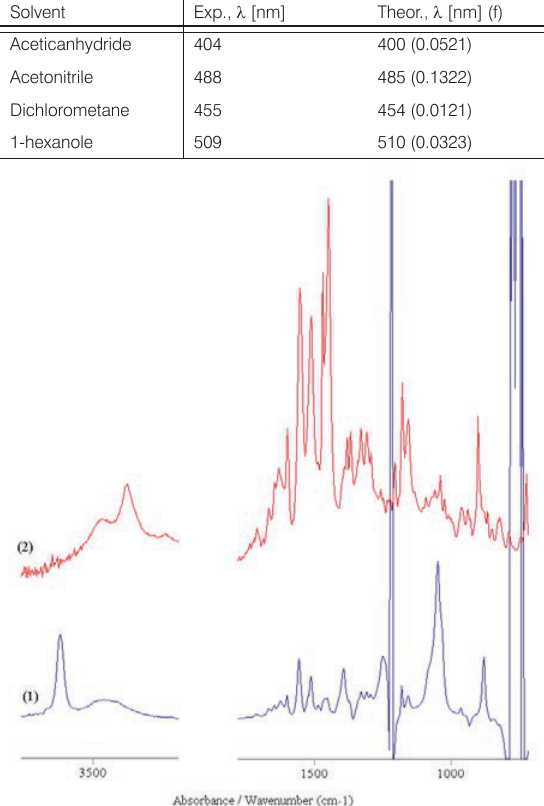
Figure 3. IR-spectra of ( E )-2-(3-(4-aminostyryl)-5,5-dimethylcyclo- hex-2-enylidene)malononitrile in solvent (1) and solid- state